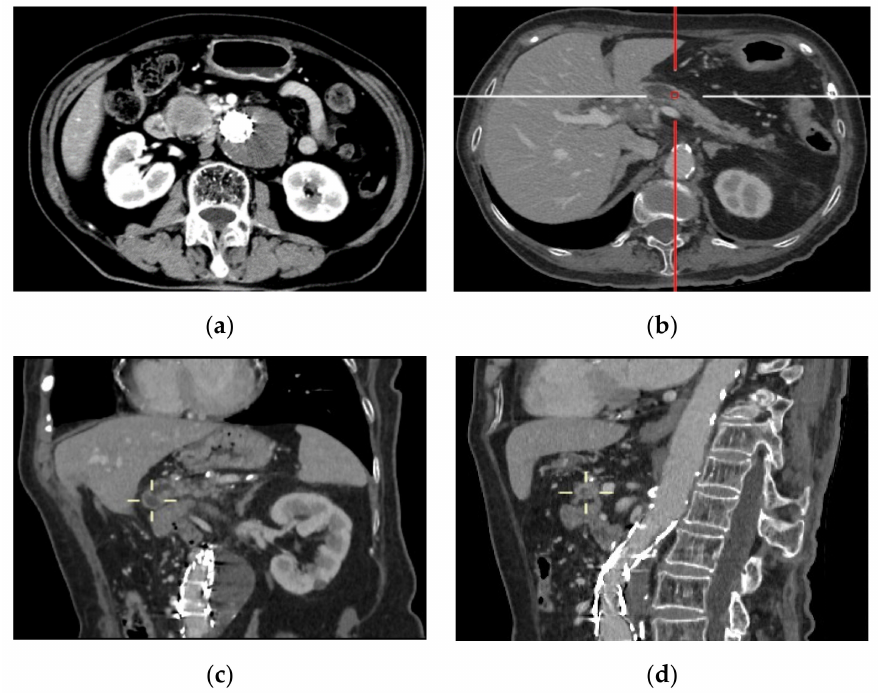
Figure 1. CT images of ( a ) intra-aortic endovascular stent in transverse arterial phase; ( b ) a solid tumor of 31 mm diameter in the pancreas head with dilatation of the central pancreatic duct in transverse venous phase; ( c ) sagittal plane showing an infrarenal AAA and the endovascular stent in coronal arterial phase; ( d ) location of pancreatic cancer and endovascular repair of AAA in sagittal venous